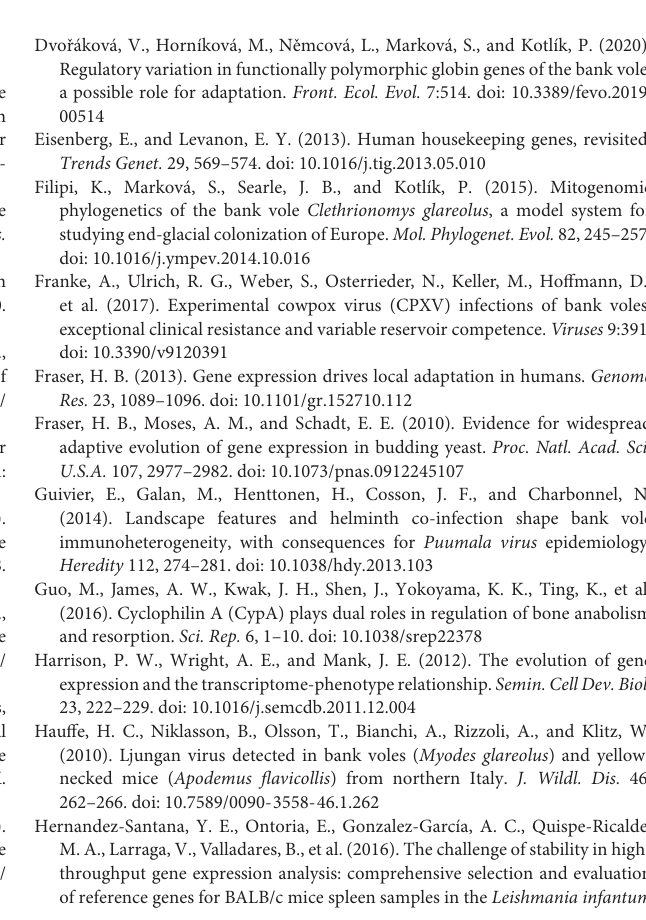
BestKeeper Index . Supplementary Table 8 | Expression stability analysis with BestKeeper based on the C t data, including the pairwise correlation of each gene with the